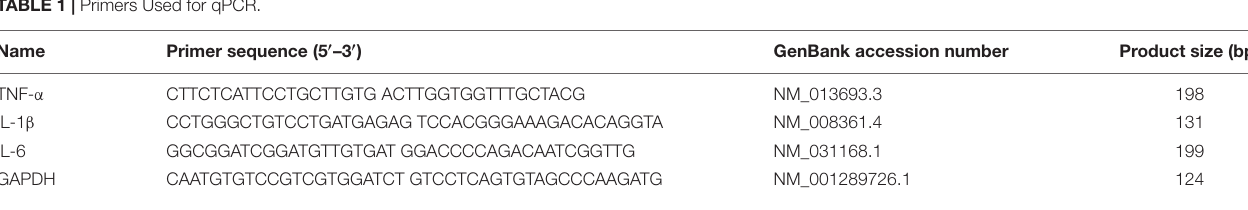
TABLE 1 | Primers Used for